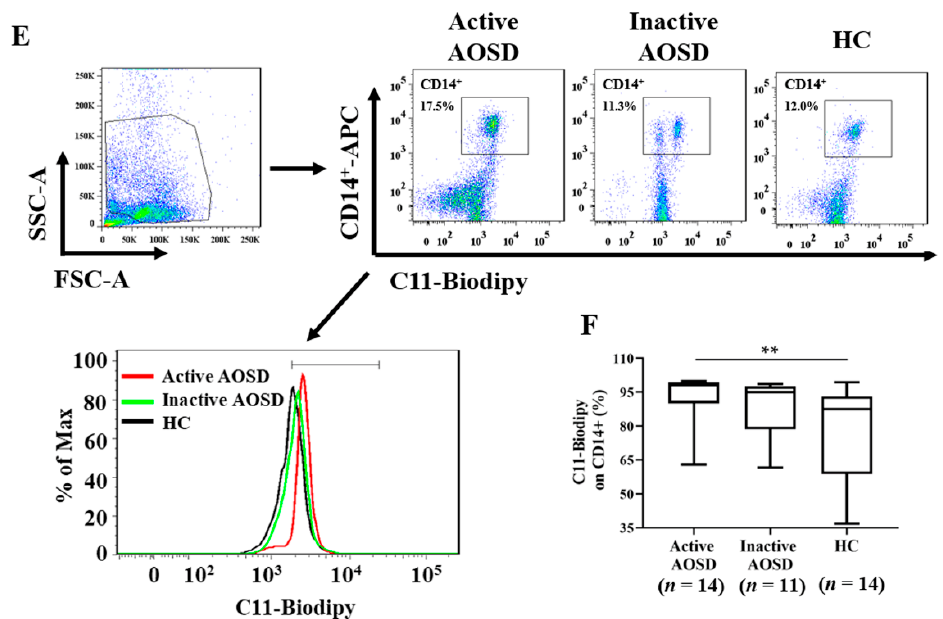
Figure 1. The C11-BODIPY 581/591 fluorescence intensity on PBMCs and CD14 + cells from adult-onset Still’s disease (AOSD) patients and healthy control (HC) subjects. The representative histograms of the C11-BODIPY 581/591 fluorescence intensity on circulating PBMC-gated cells ( A ) or CD14 + -gated cells ( C ) obtained from one active AOSD patient, one inactive AOSD patient, and one HC subject. Comparisons of the mean fluorescence intensity (MFI) of C11-BODIPY 581/591 on PBMC-gated cells ( B ) or CD14 + -gated cells ( D ) among active AOSD patients, inactive AOSD patients, and HC subjects. ( E ) Dot-plots of C11-BODIPY 581/591 level on circulating allophycocyanin (APC)-CD14 + cells from one of the different groups. After gating on monocytes (CD14+ cells), the percentages of positive C11- BODIPY 581/591 were calculated. ( F ) Comparisons of the percentages of C11-BODIPY 581/591 -positive CD14 + cells were evaluated among active AOSD patients, inactive AOSD patients, and HC subjects. The data are presented as box-plot diagrams, in which the box encompasses the 25th percentile (lower bar) to the 75th percentile (upper bar). The horizontal line within the box indicates the median value for each group. The p -values were determined by using the Kruskal–Wallis test. * p -value < 0.05, ** p -value < 0.01.